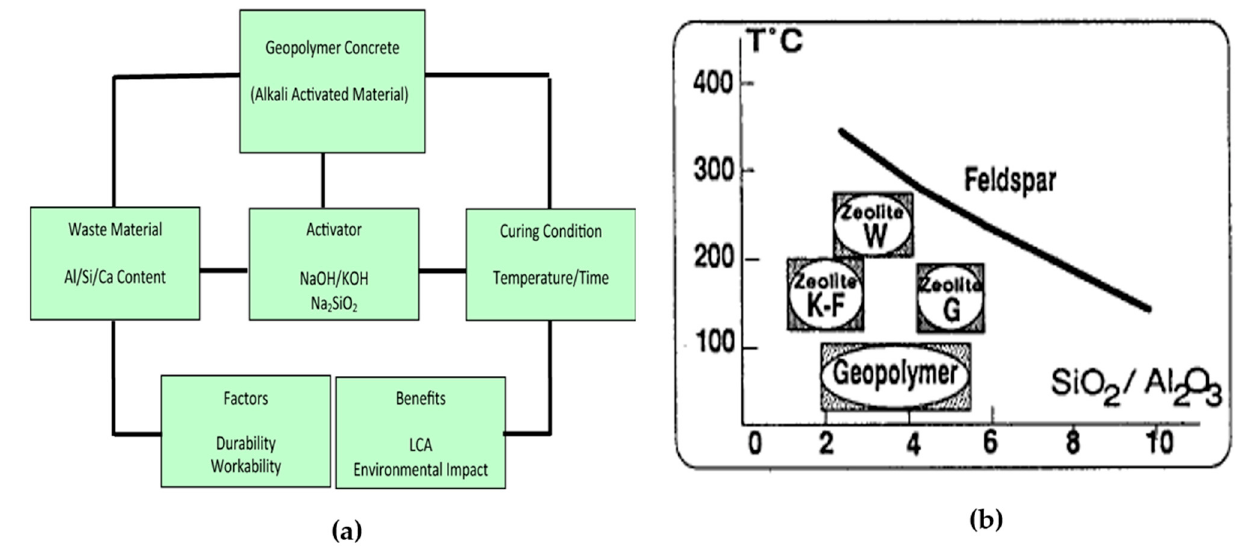
Figure 2. ( a ) Mechanism of Geopolymerisation; ( b ) crystallisation temperature ranges for K 2 O-Al 2 O 3 - SiO 2 system [21].